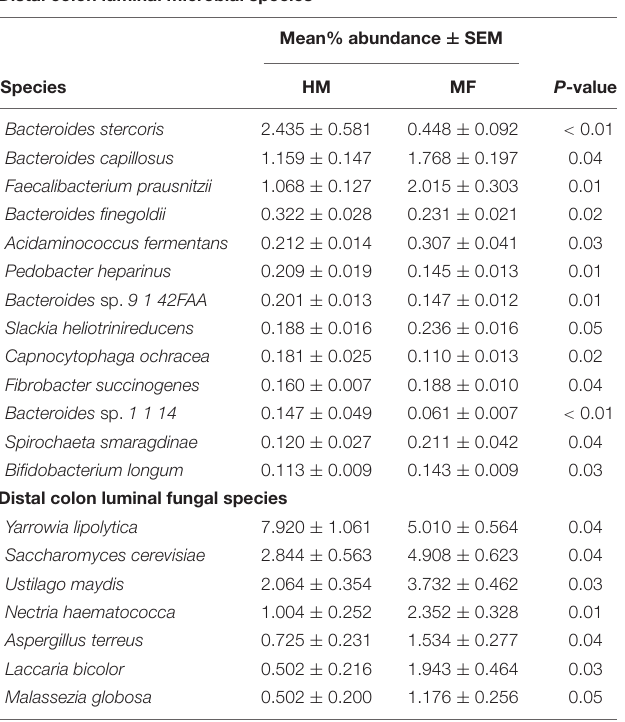
TABLE 4 | Relative abundances of significant ( P ≤ 0.05) colon-associated bacterial and fungal species detected postweaning (i.e., day 51 of age) in male piglets fed with human milk (HM) or milk formula (MF) during the preweaning period from day 2 until day 21 of